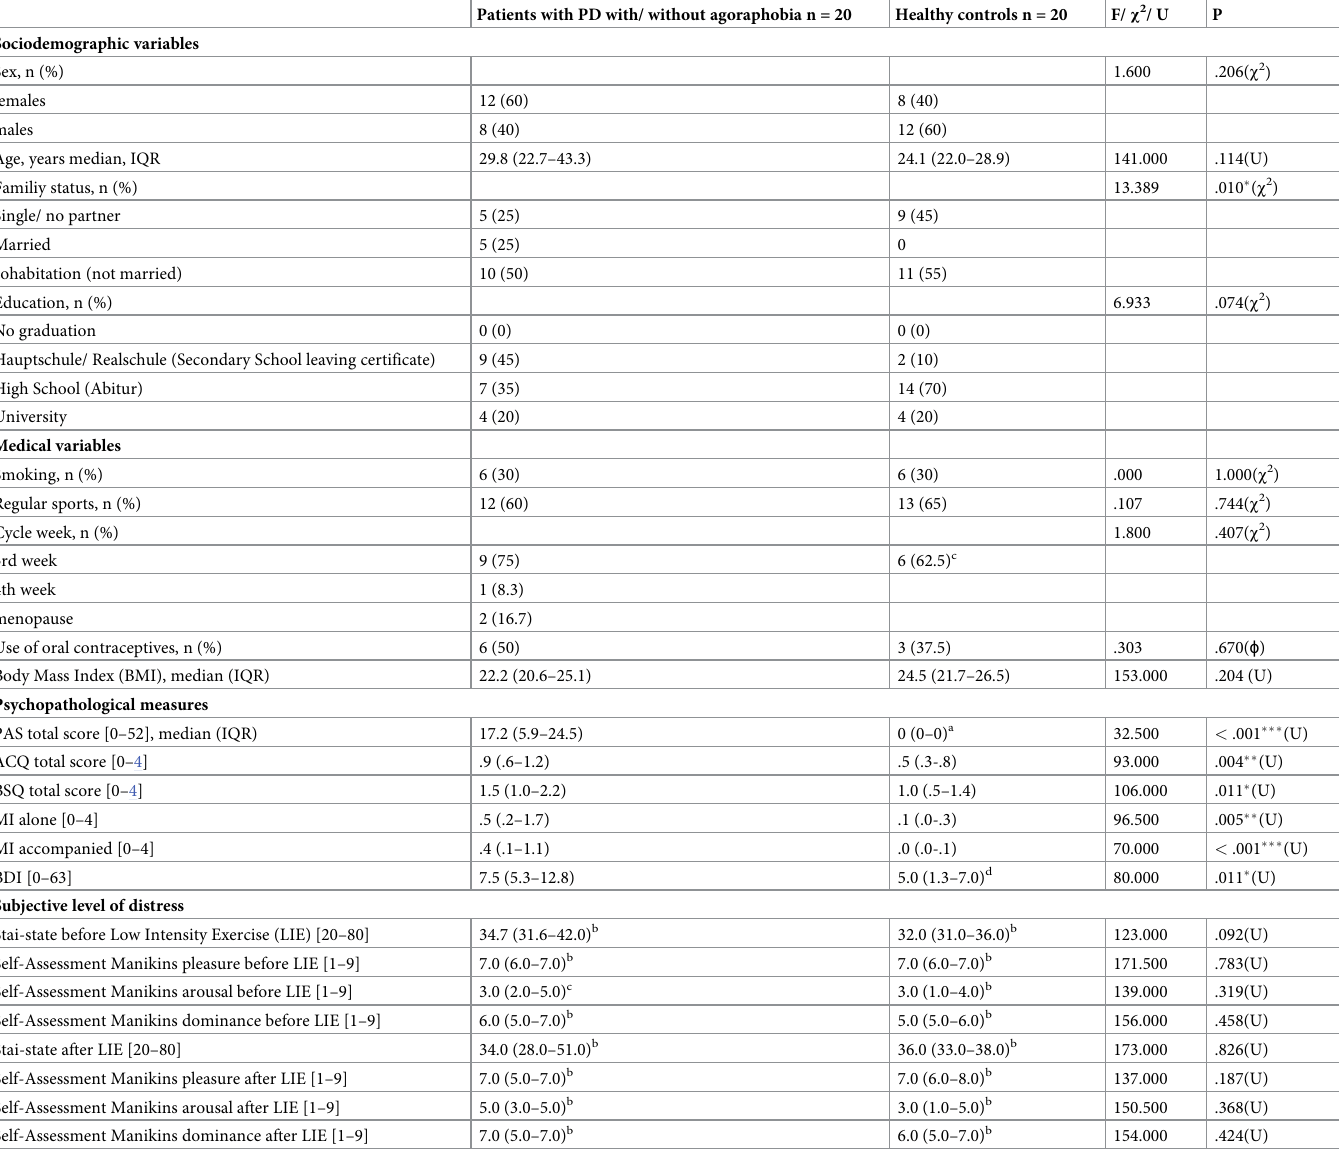
Table 1. Sociodemographic, medical, psychopathological variables and subjective level of distress of the N = 20 patients with PD with/ without agoraphobia and a sample of healthy controls (N = 20). Patients with PD with/ without agoraphobia n = 20 Healthy controls n =